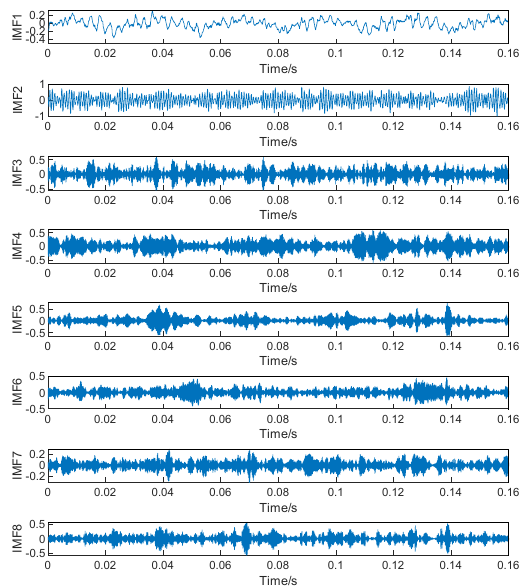
Figure 23. The fitness function varies with the number of iterations. After obtaining the optimal parameter combinations of the number of components and the penalty factor in the VMD method as K 0 = 8 and α 0 = 904, respectively, perform VMD processing on the fault signal, and obtain eight IMF components, as shown in Figure 24.